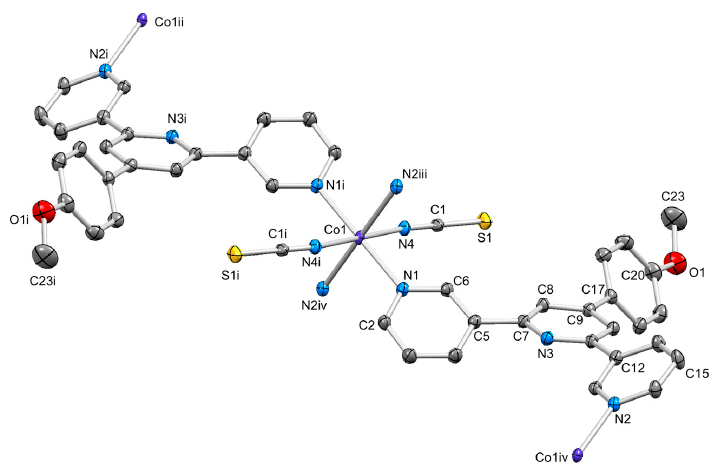
Figure 8. The repeating unit in the 2D network in [{Co( 2 ) 2 (NCS) 2 } · 3MeOH] n with symmetry generated atoms; ellipsoids are plotted at a 40% probability level, and H atoms omitted for clarity. Symmetry codes: i = 1– x , 1– y , – z ; ii = 1 / 2 – x , 1 / 2 + y , – 1 / 2 – z ; iii = – 1 / 2 + x , 1 / 2 – y , – 1 / 2 + z